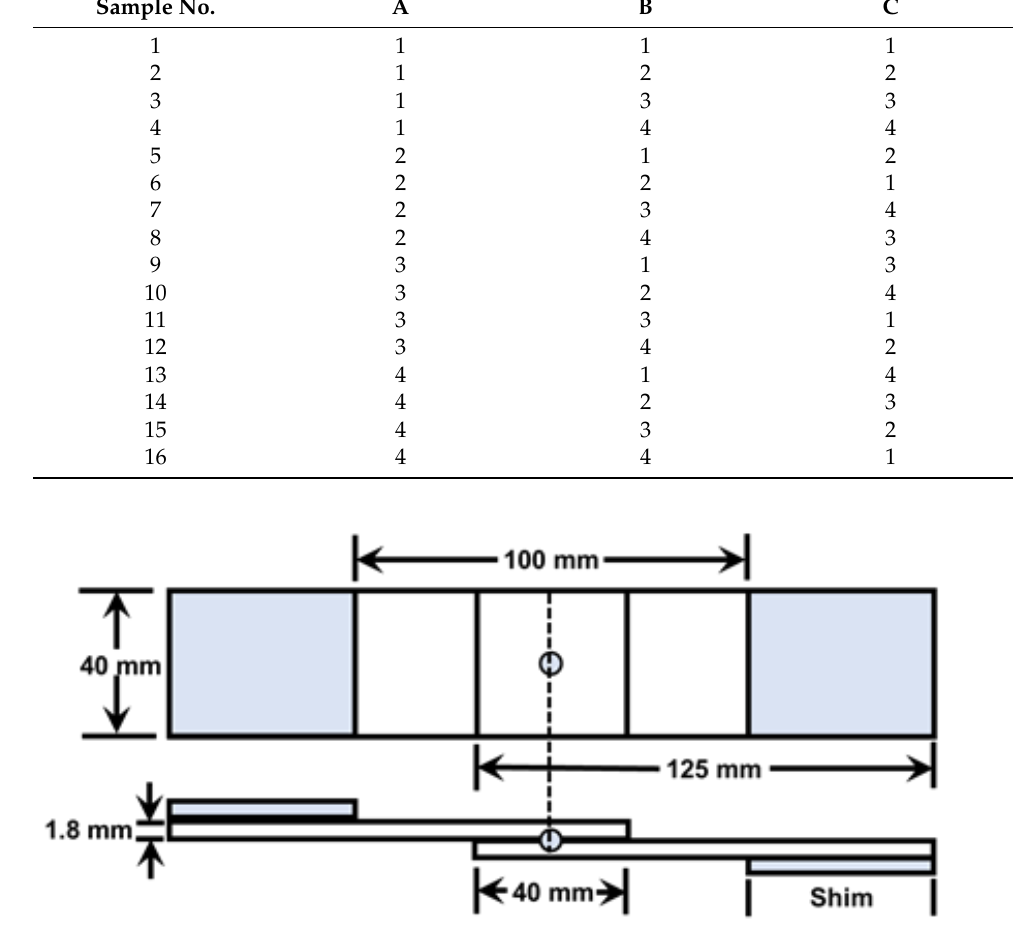
Figure 2. Schematic of lap shear tensile